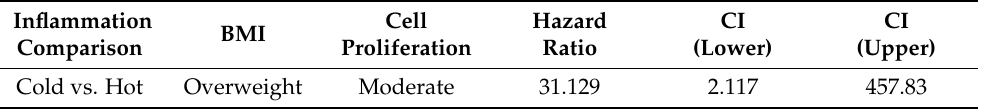
Table 4. PFS in interaction model for inflammation